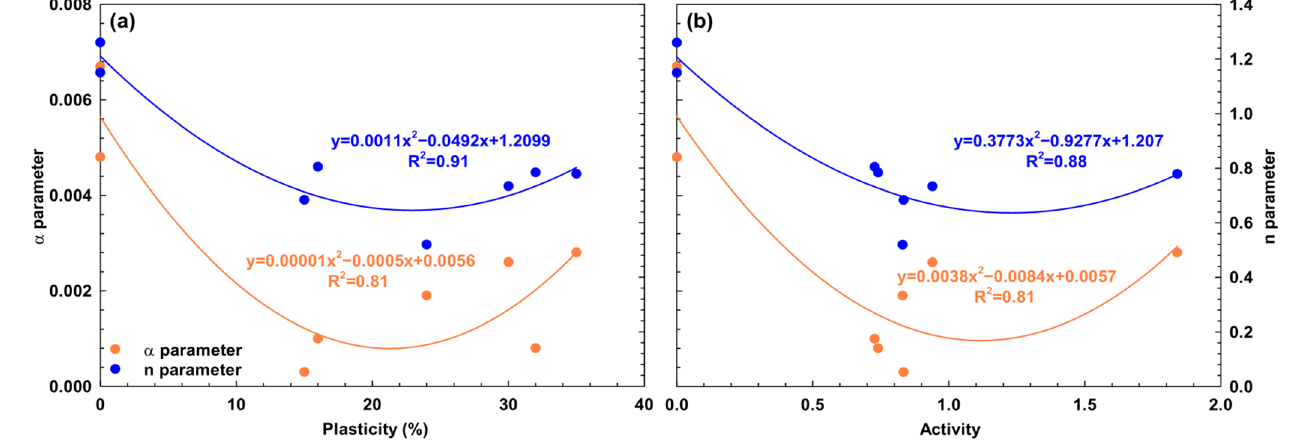
Figure 10. Relationship between VG fitting parameters and mineralogical properties: ( a ) plasticity (%) and ( b ) activity.